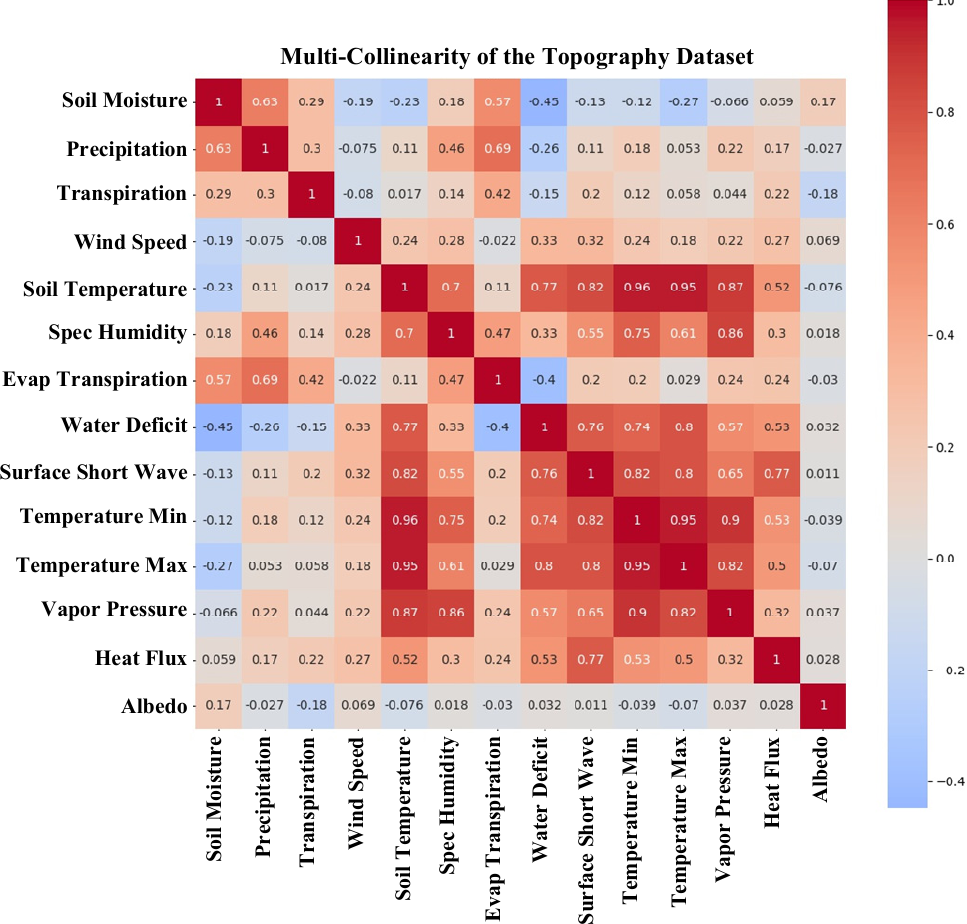
Figure 12. The correlation matrix of topography factors as a heatmap.